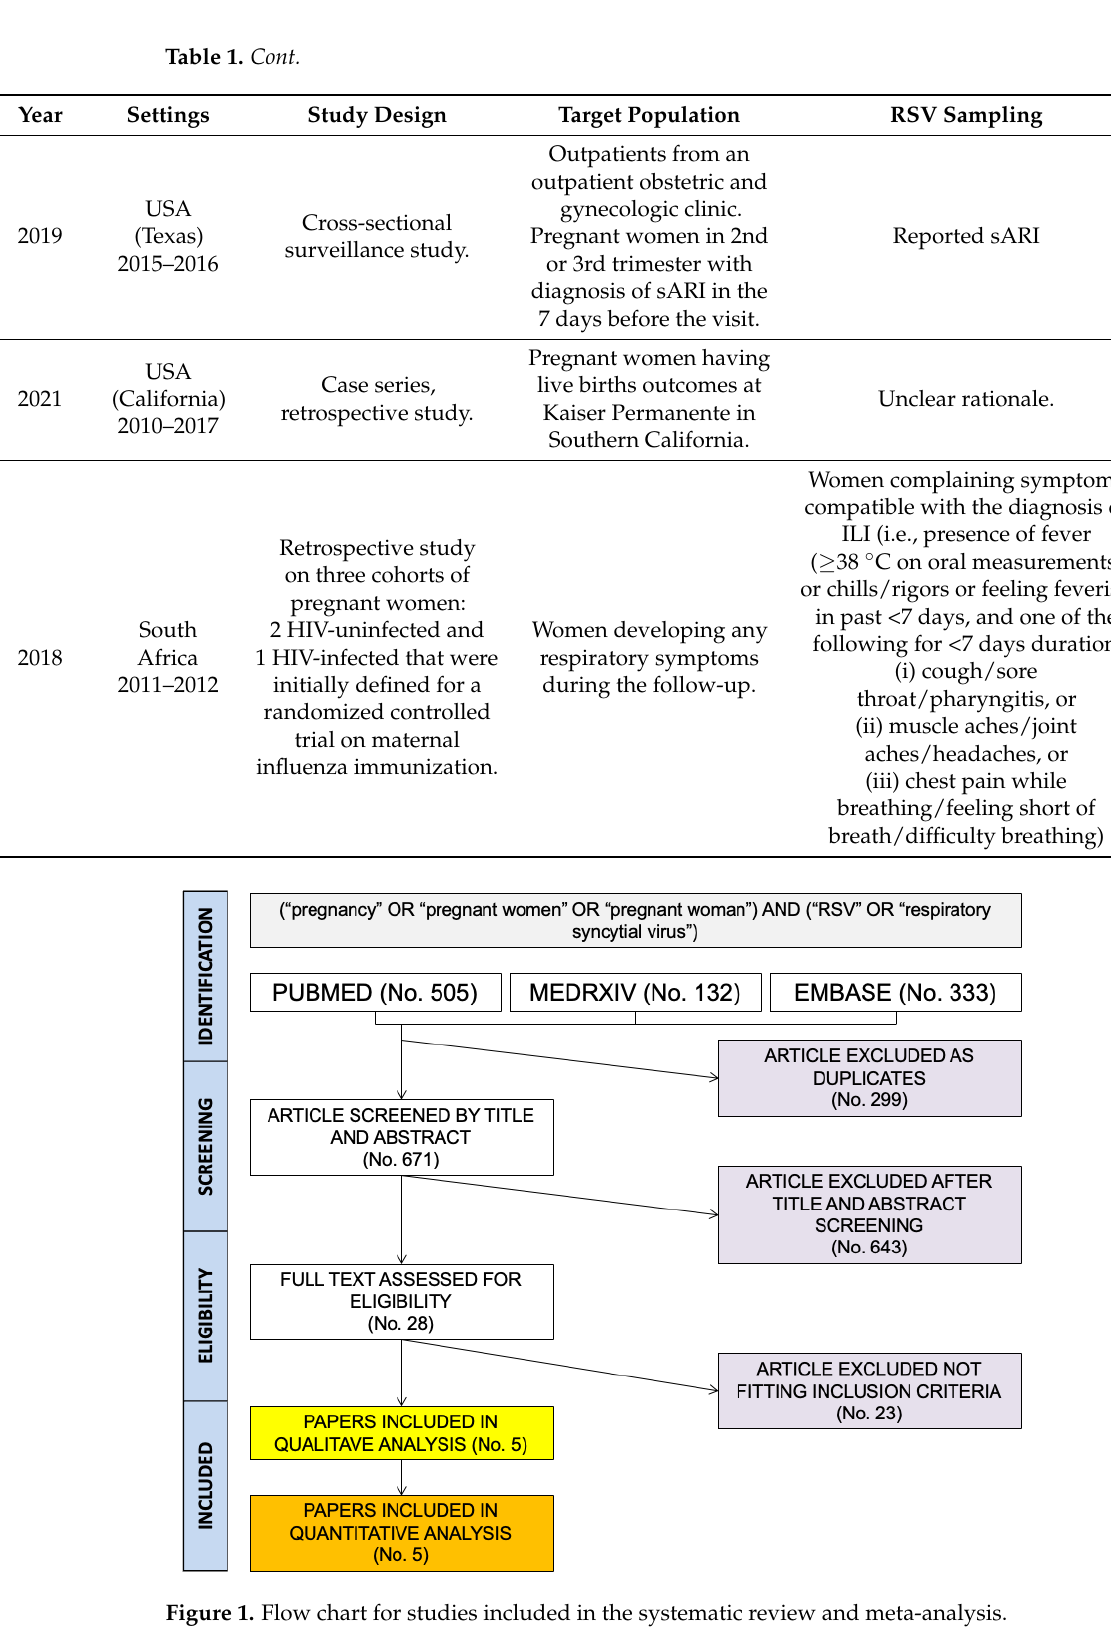
Table 1. Summary description of individual studies.